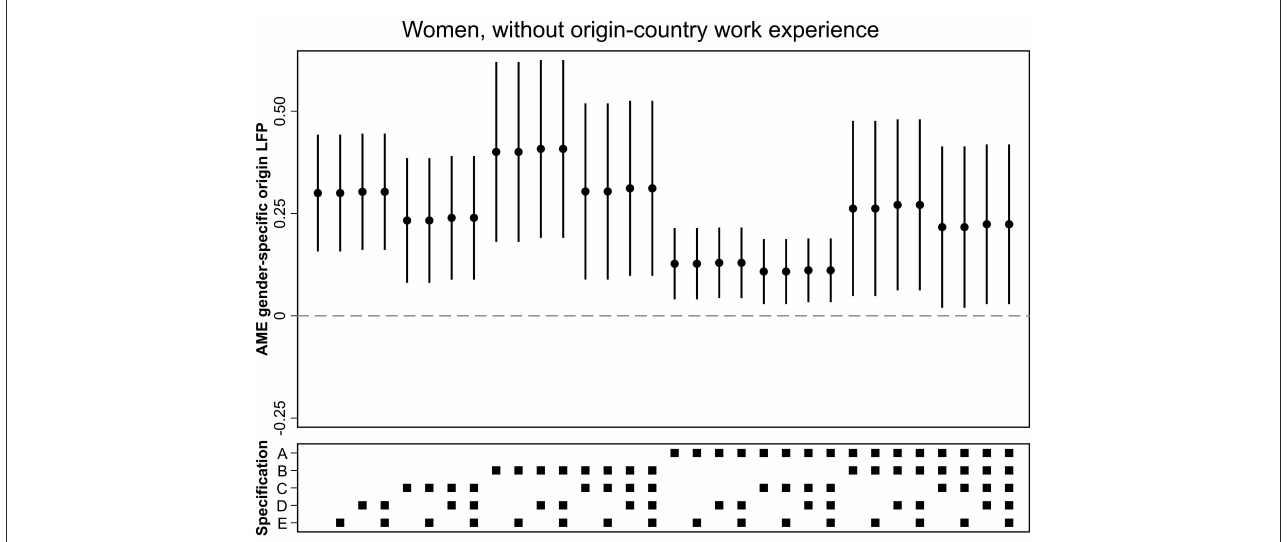
FIGURE3 Sensitivity analysis of H1. AME (with 95% confidence intervals from robust standard errors) on employment for gender-specific origin-country LFP for women without origin-country work experience. (A) Outcome variable participation; (B) alternative definition of employment/participation; (C) LFP ratio instead of rate; (D) predicted LFP; (E) minimum 20 years of immigration